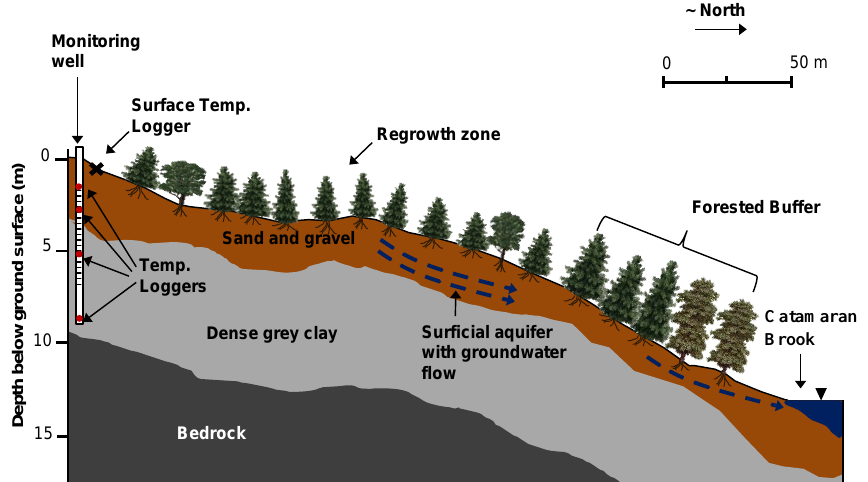
Fig. 2. Cross-sectional view of the portion of the Catamaran Brook catchment containing the monitoring well and temperature loggers (adapted from Alexander,